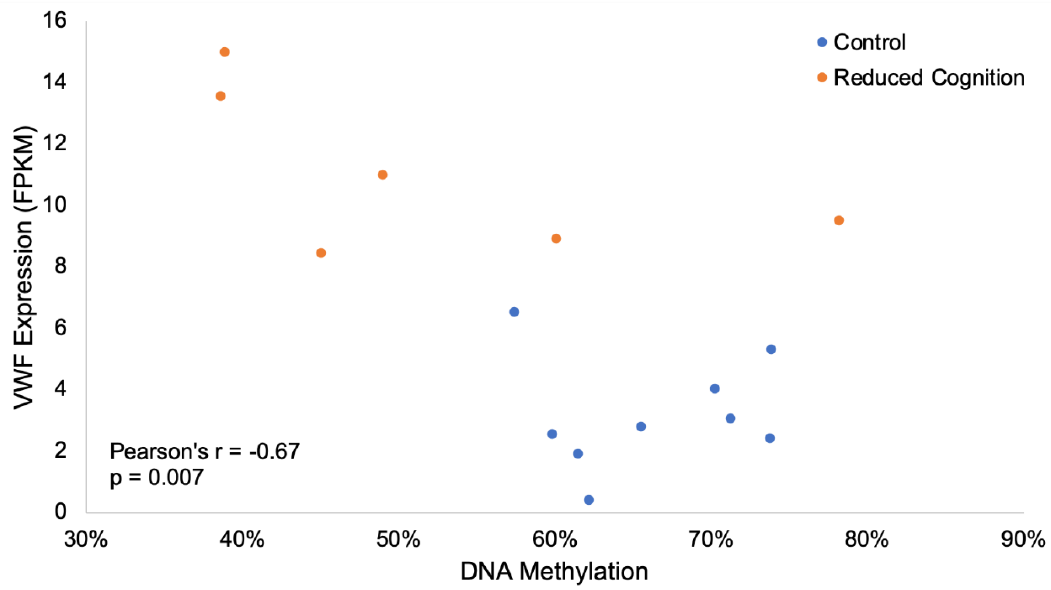
Figure 5. Di ff erential methylation and expression of VWF. Hypomethylation of a 28 bp region in the 11 th intron of VWF correlated with increased expression in the reduced cognition group (Pearson’s R = −0.67, p -value = 0.007).